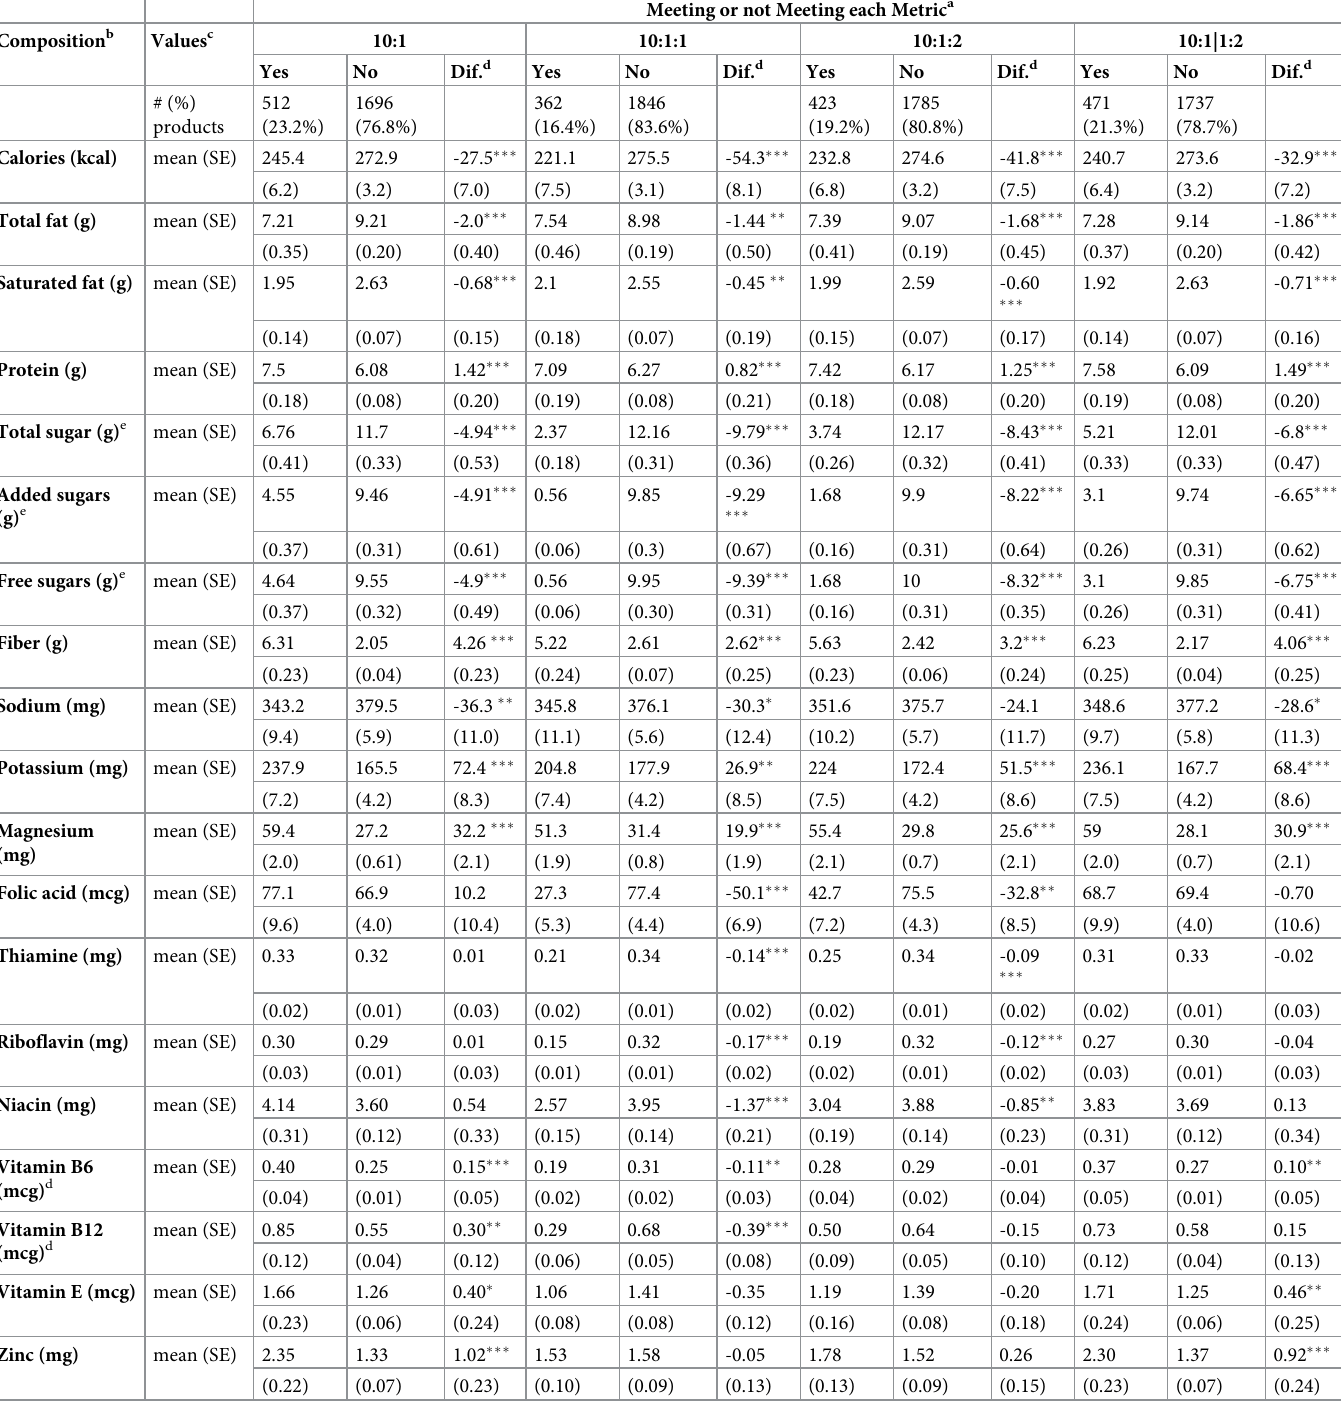
Meeting or not Meeting each Metric a